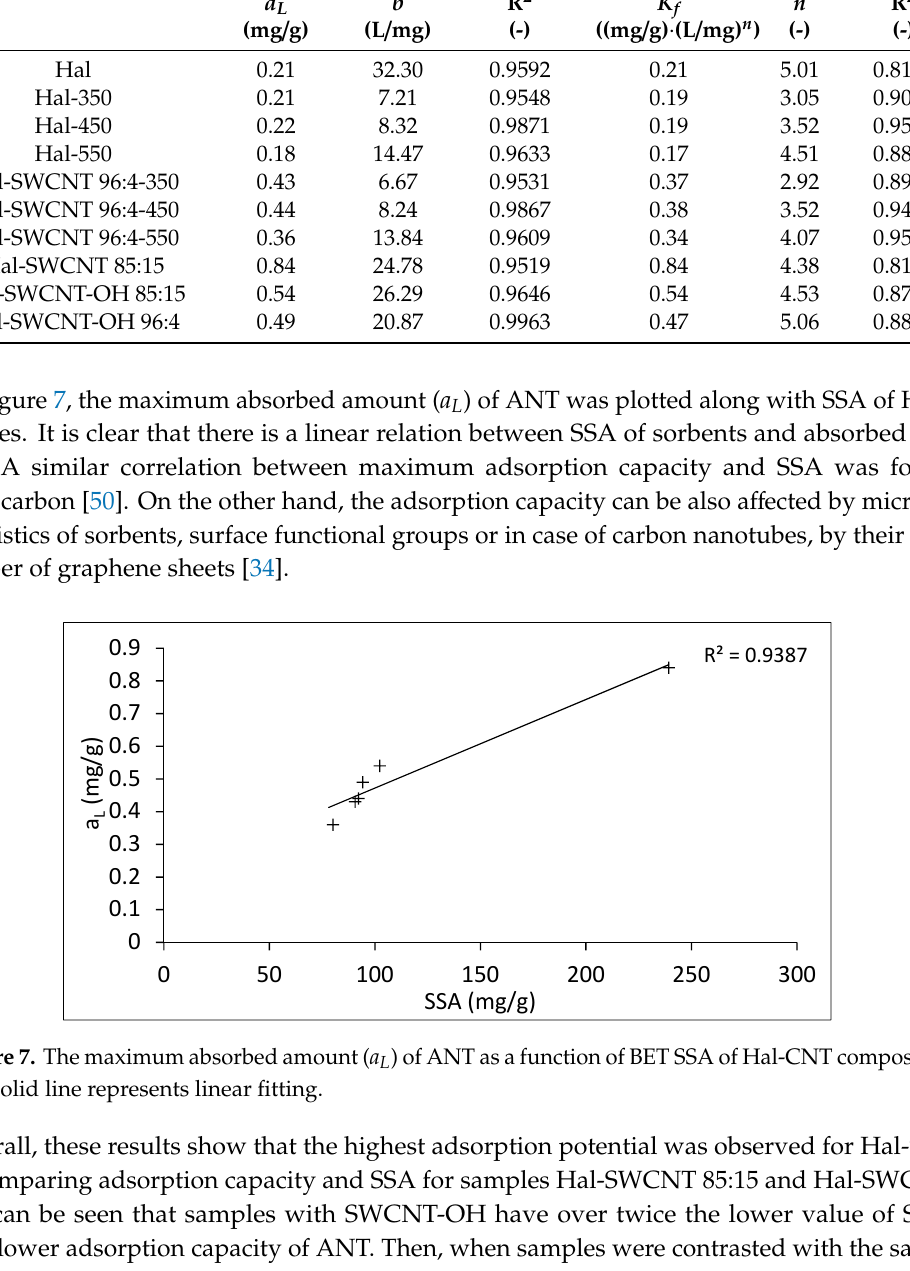
Figure 8. Adsorption kinetic curves of ANT on Hal, Hal-350, Hal-450, Hal-550 and Hal-CNT composites. The experimental data were fitted using pseudo first kinetic order and pseudo second kinetic equations expressed as follows, respectively [34]: 𝑙𝑛 (𝑄 (cid:3032) − 𝑄 (cid:3047) ) 𝑄 (cid:3032)